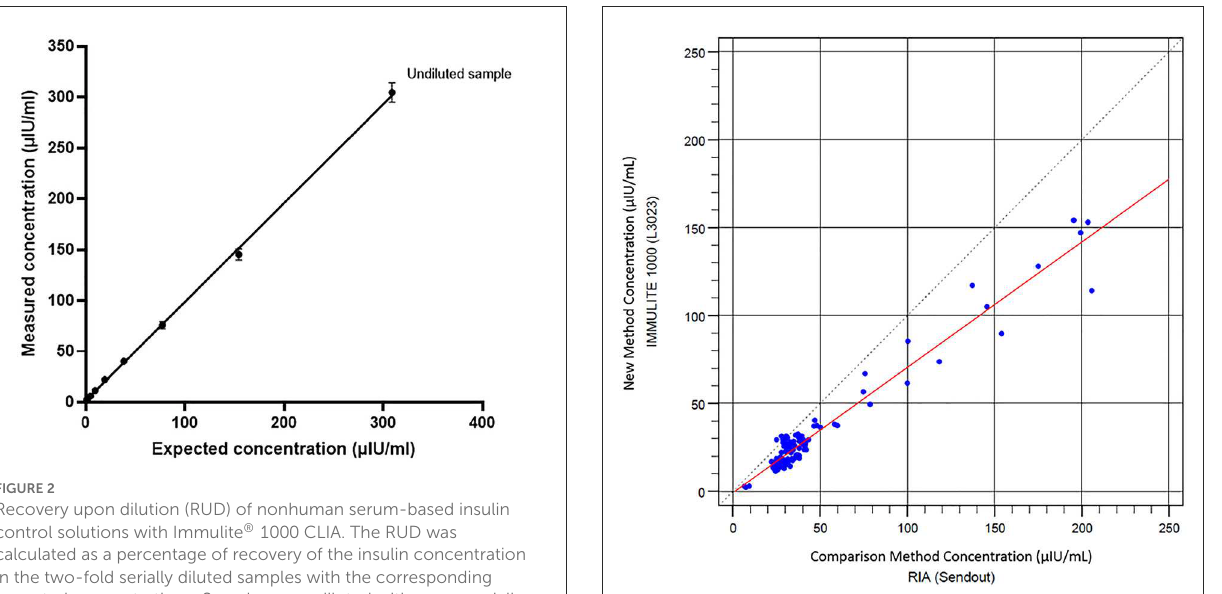
Scatter plot of Immulite ® 1000 CLIA compared with RIA results. Least square regression analysis indicates a best-fit line (red) y = 0.713 x –